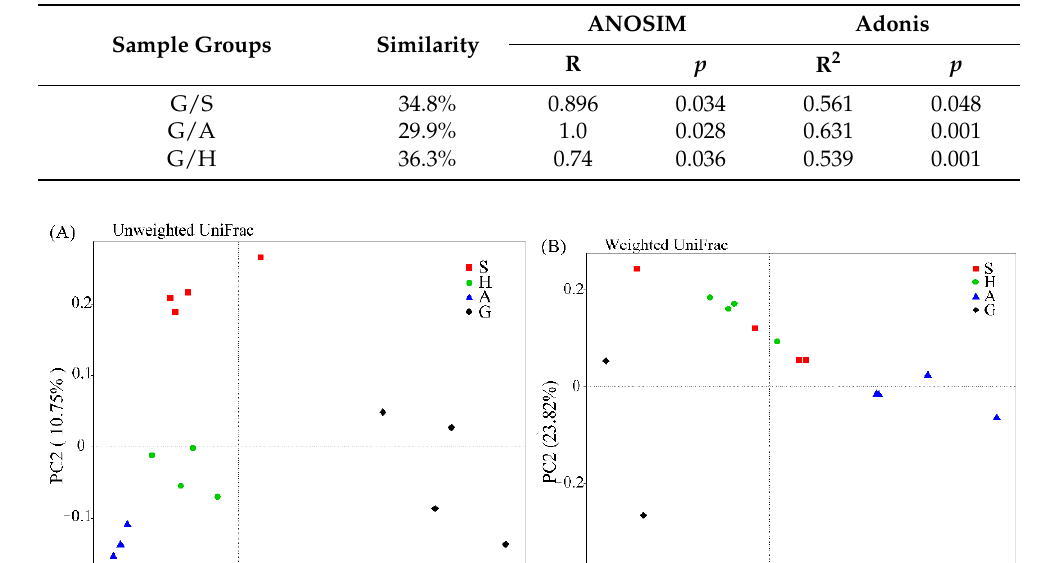
Figure 1. The α -diversity indices of the microbial composition in the worm intestine and different sediments from a Sipunculus nudus aquaculture area. ( A ) Number of observed OTUs. ( B ) Shannon diversity index. ( C ) Chao1 index. Asterisks (*) indicate significant differences ( p < 0.05, Wilcoxon test). S—surface sediment; H—sediment in the hole; A—ambient sediment; G—gut of S. nudus . Table 1. Similarity and ANOSIM/Adonis analyses of microbial communities in intestine and sedi- ment samples based on Bray-Curtis dissimilarity.